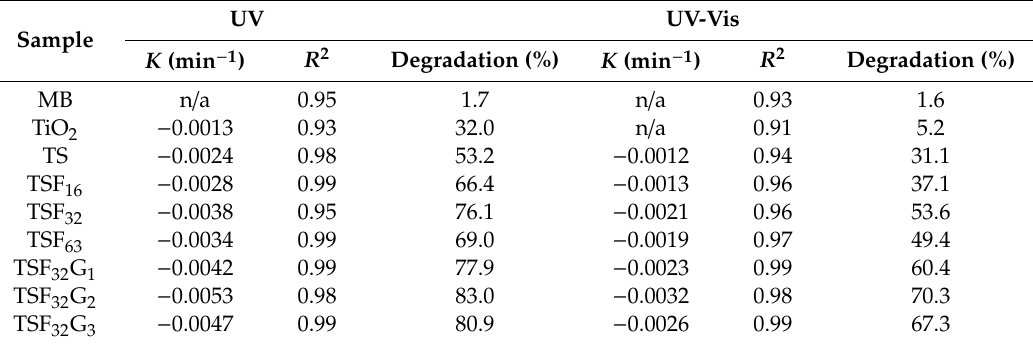
Table 3. Self-cleaning performance of different coated films.